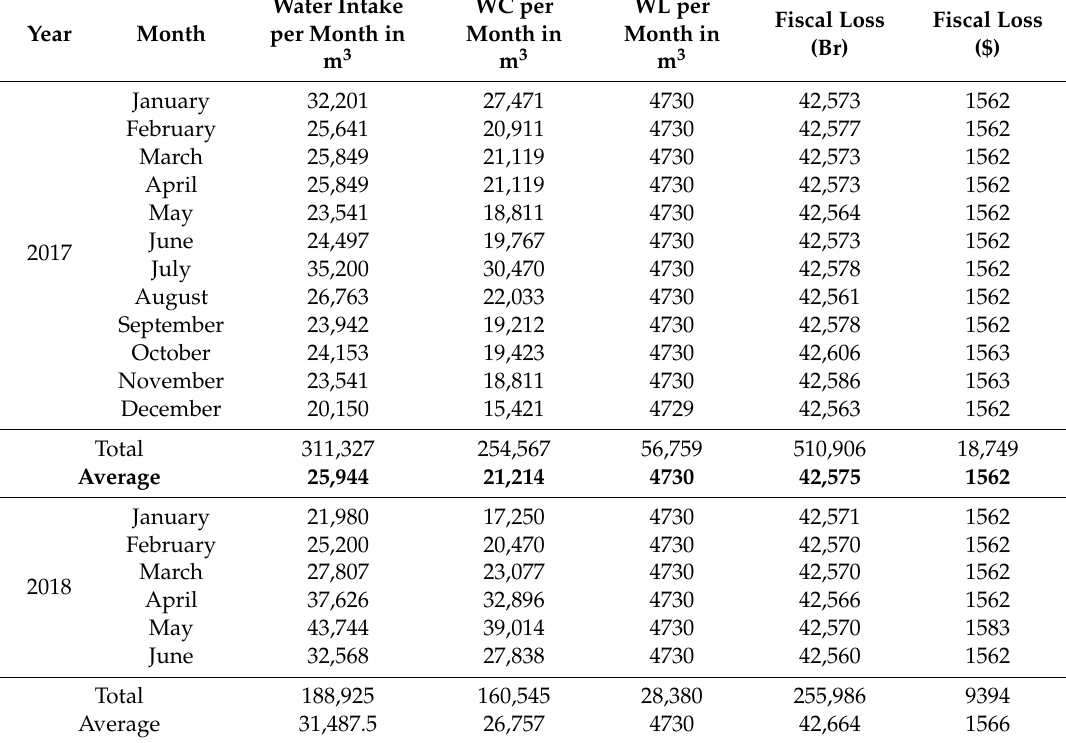
Table 1. Details of water intake, water consumption (WC), water leakage (WL), fiscal loss in Br and use